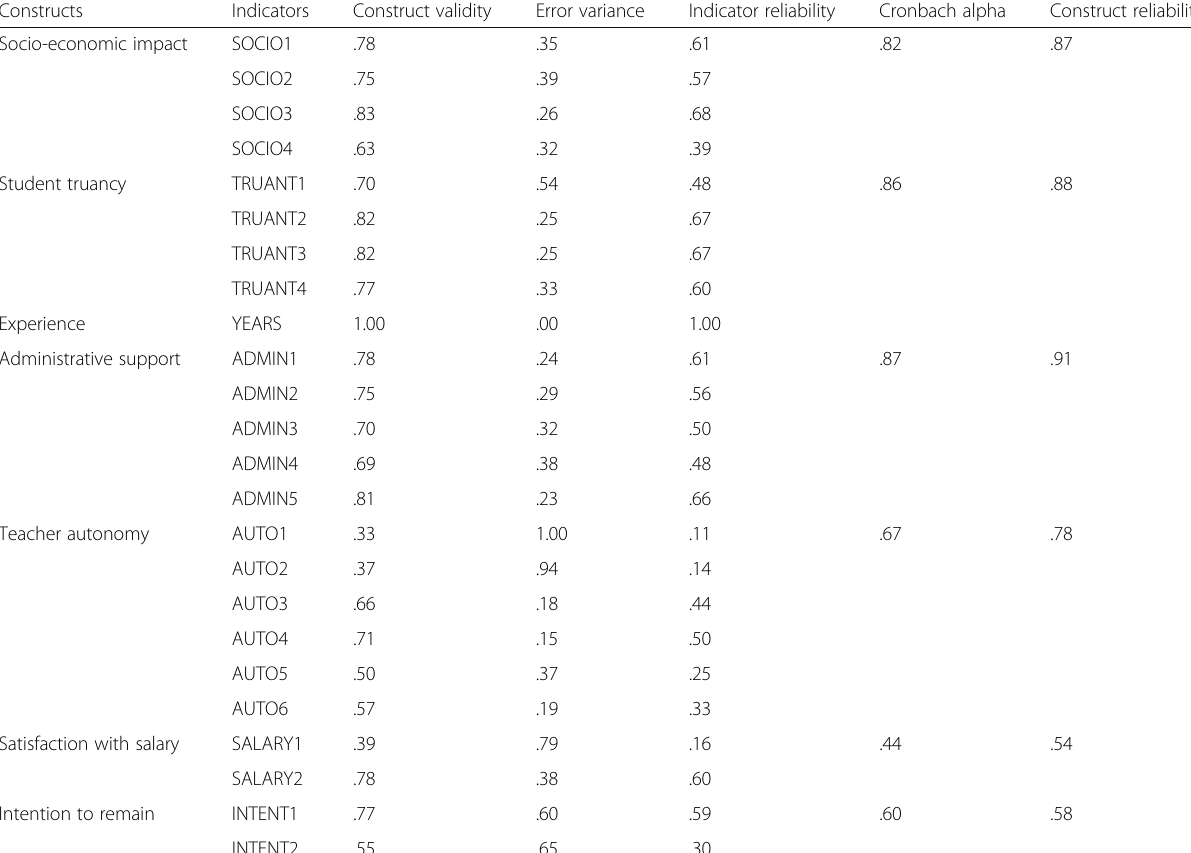
Table 4 Validities and reliabilities for constructs and indicators